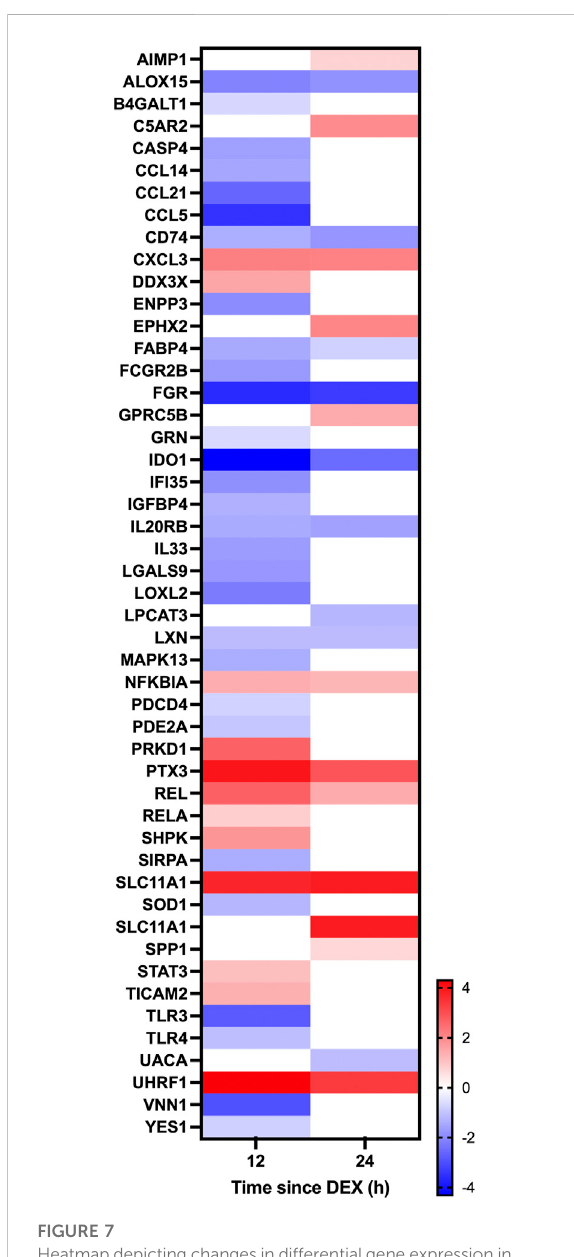
12 h post-DEX, while only two genes (DLG3 and YBX3) were